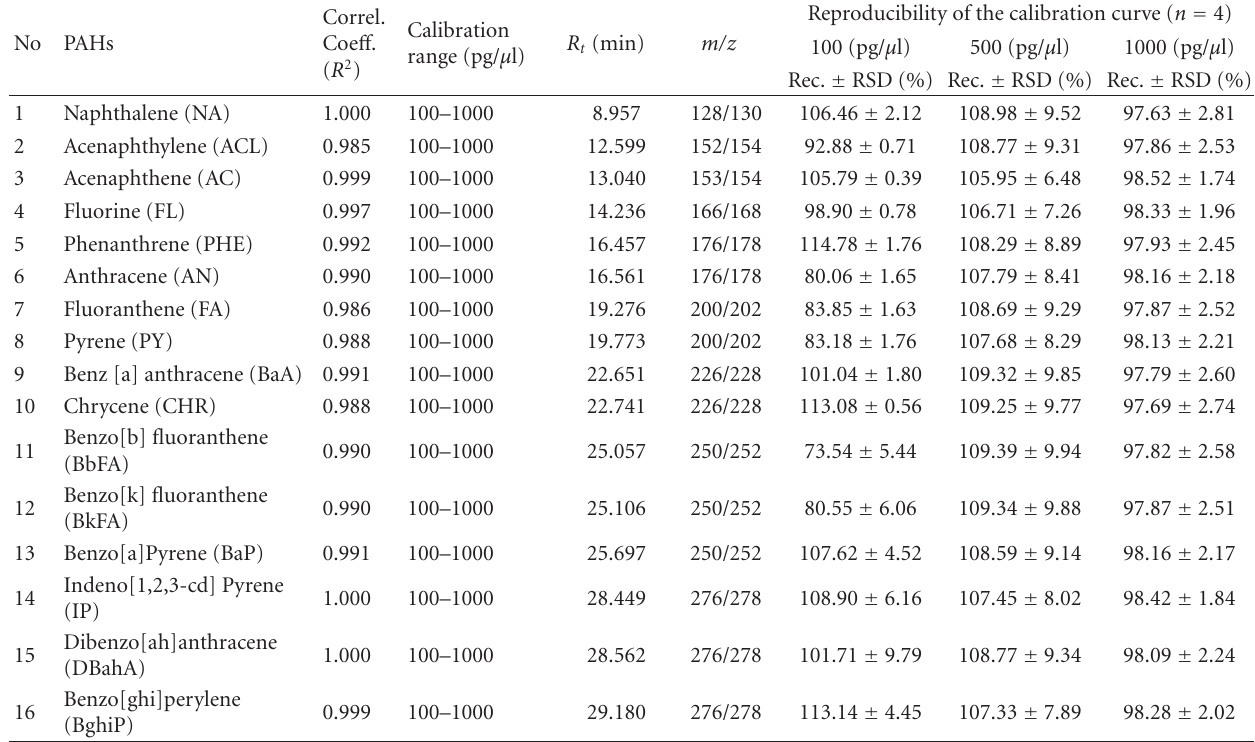
Table 2: Calibration characteristics of the 16